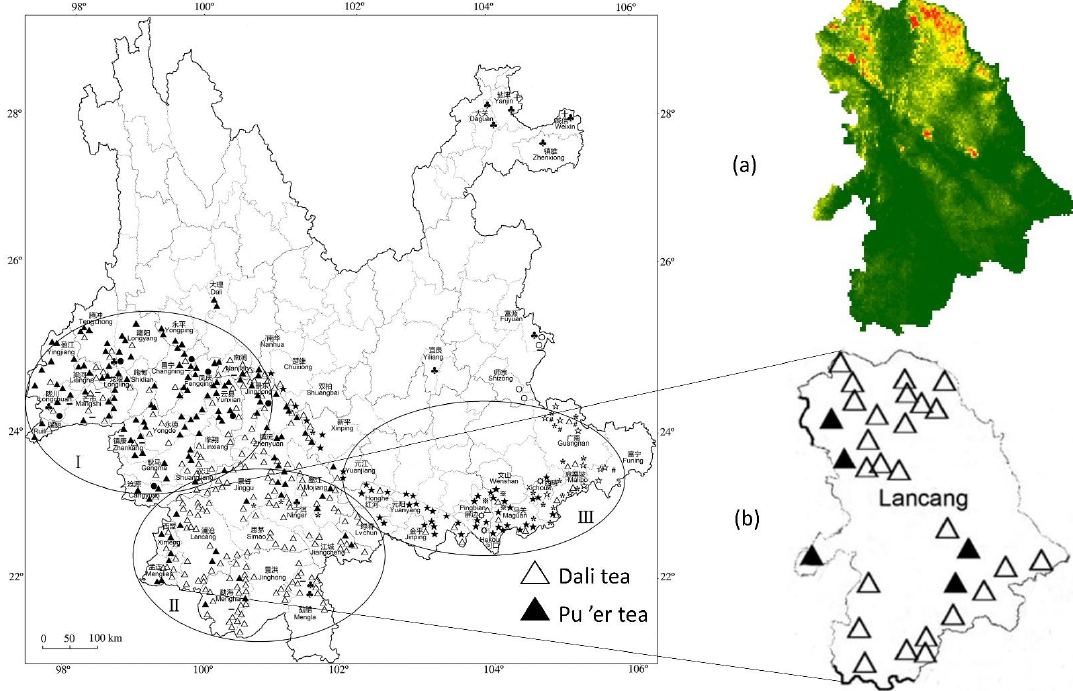
Figure 4. The distribution of ancient tea resources in Yunnan from Jiang, Tang, Chen, Wang, Cai, Yu, Yang, Wang, Li, Jiang, Wang, Duan, Li, He, Wang, Li and Bu [54] (Figure 2, p. 300). The hollow triangle represents the Dali tea species ( Camellia taliensis (W. W. Sm.) Melch.), and the solid triangle represents the Pu’er tea species. Other symbols also represent tea species, but the legend was omitted, and we only kept the two species that occurred in this county as legends for better visualization. There are three major distribution areas of Yunnan's ancient tea resources: western Yunnan (I), southern Yunnan (II), and southeast Yunnan (III), and we focused on southern Yunnan. We extracted the data of Lancang Lahu Autonomous County (test set) from our model ( a ) and the map ( b ) to evaluate model performance. We analyzed the effects of climate change on the suitable areas of ancient Pu’er tea trees over 80 years, from 2021 to 2100, and expanded the extent of the model to a nation- wide and global scale. The model in Pu’er predicted a southwestward and southward expansion of the suitable areas over the following 80 years. Although small shifts in the distribution are possible, the general distribution is likely to remain stable. We found that the area of high environmental suitability will increase and decrease in Sichuan and Xi- zang provinces, respectively (Figure 5). Detailed area shifts are shown in Table 2. Overall, the area of high and medium environmental suitability was predicted to be higher in Yun- nan, Guangxi, and Guizhou provinces in 2100 relative to 2021; environmentally suitable areas in Xizang are predicted to decrease over this same period. Potentially suitable areas for ancient Pu‘er tea trees occurred in sev eral countries (Figure 6). Countries with high environmentally suitable areas include China, Vietnam, Laos, Myanmar (Burma), Thai- land, India, Bhutan, Nepal, Ethiopia, Tanzania, Zimbabwe, South Africa, Swaziland, Mad- agascar, the United States, Mexico, Guatemala, Colombia, Peru, and Brazil. However, the most suitable area occurs in Asia.